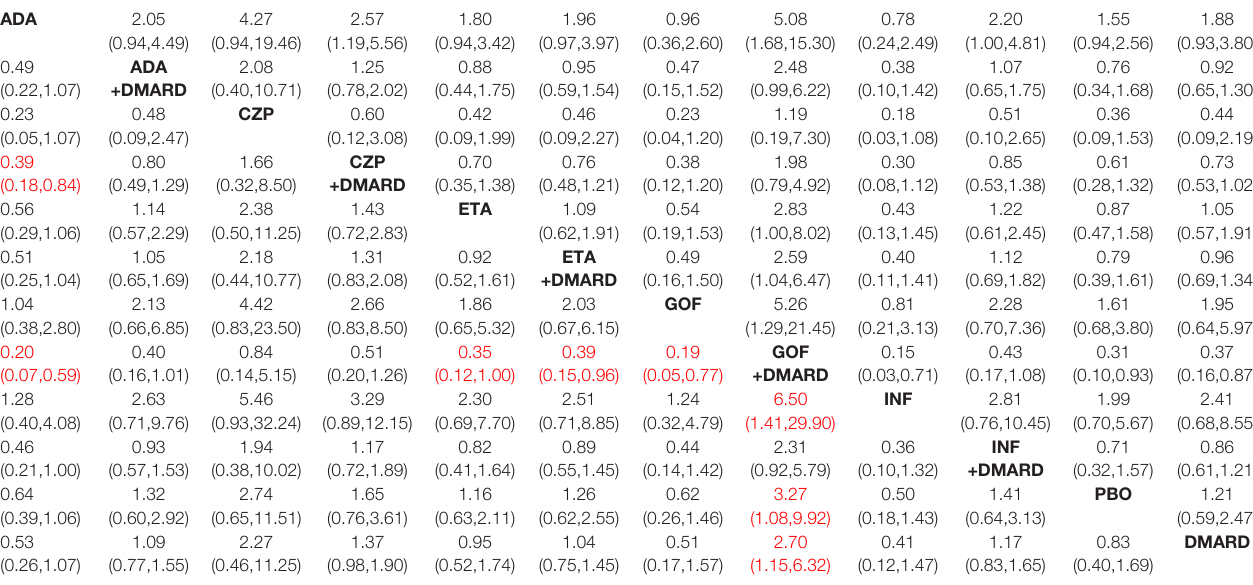
TABLE 3 | OR of serious adverse events of 12 therapies.